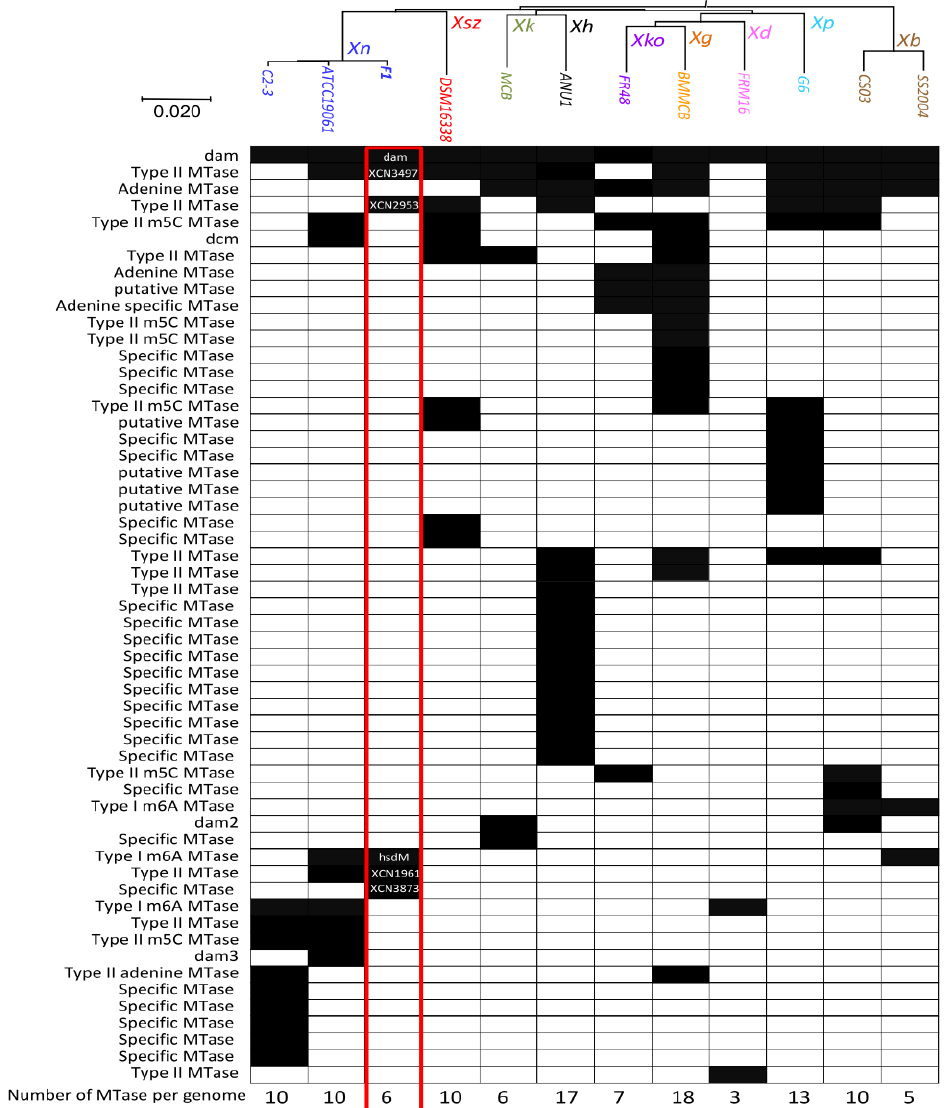
Figure 1. Diversity of putative DNA-methyltransferase (MTases) in 12 Xenorhabdus genomes. The distribution patterns of putative ortholog MTases among Xenorhabdus genomes is presented. Black square: presence of the MTase in the Xenorhabdus genome; white square: absence of the MTase. The phylogenetic tree (at the top of the figure) is based on complete Xenorhabdus genome sequences (see Materials and Methods section for details), Xenorhabdus species are color-coded, and the corresponding abbreviations are indicated ( Xb , X. bovienii ; Xd , X. doucetiae ; Xg , X. griffinae ; Xh , X. hominickii ; Xk , X. khoisanae ; Xko , X. kozodoii ; Xn , X. nematophila ; Xp , X. poinarii , and Xsz , X. szentirmaii ). The number of MTases per genome is indicated at the bottom of the